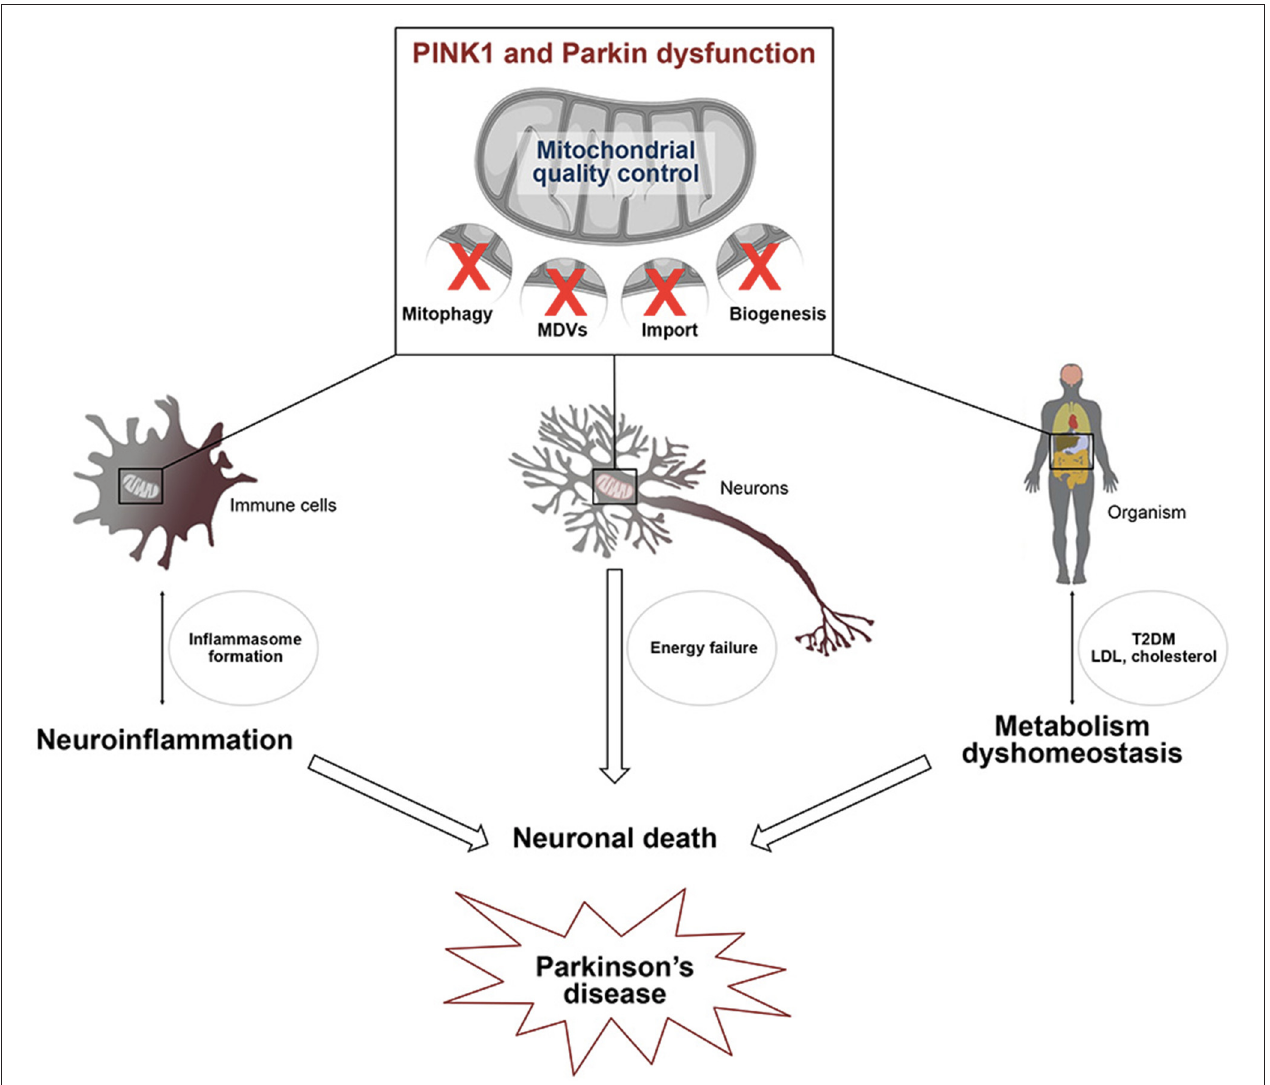
FIGURE 2 | Defects in mitochondrial quality control affect several pathways linked to Parkinson’s disease. PINK1/Parkin-dependent mitochondrial quality control, including mitophagy, the MDV pathway and mitochondrial biogenesis, is essential for cell viability. Alterations of this process in several cell types may be linked to 1/ microglial activation leading to the transcriptional induction of genes encoding components of the NLRP3 inflammasome and IL-1 β 2/ energy failure in neurons, due to the presence of damaged mitochondria and 3/ type 2 diabetes (T2DM) and low density lipoprotein (LDL) cholesterol accumulation. Activation of the innate immune system, metabolism dyshomeostasis and energetic defects contribute to neuronal death which is closely linked to Parkinson’s disease.